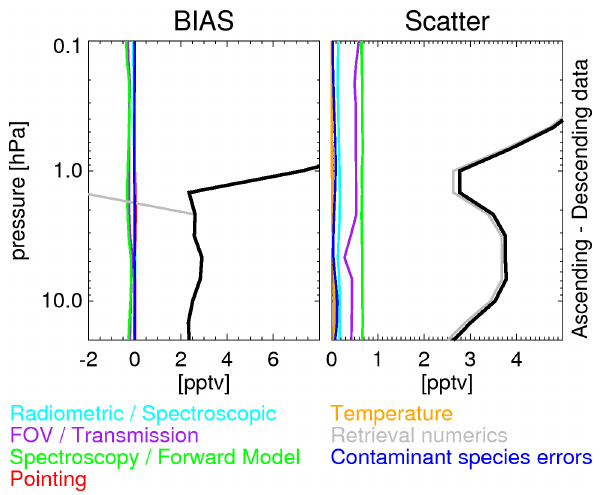
Fig. 6. Estimated impact of various families of systematic errors for ascending-descending MLS OL2 BrO observations. The left panel shows the possible biases (the difference of the ascending- descending biases in Fig. 5) and the right panel shows the additional scatter introduced by each family of systematic errors (the root sum squares of the scatter in Fig. 5). The black lines are the root sum squares of all the biases or the scatters shown.